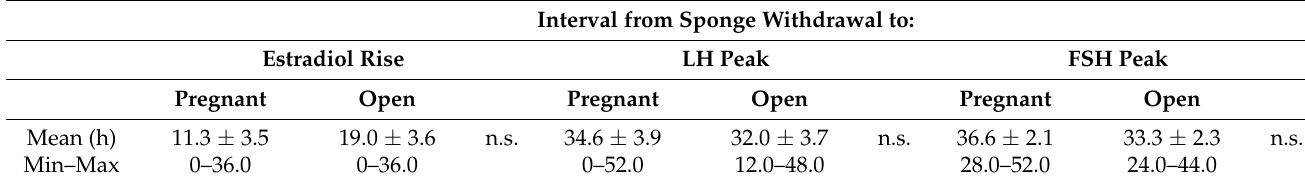
Table 1. Average intervals ( ± SEM; h) from the end of the treatment (i.e., sponge withdrawal) to the estradiol rise and LH/FSH peaks in pregnant and open goats. n.s.: no significant differences. Interval from Sponge Withdrawal to: